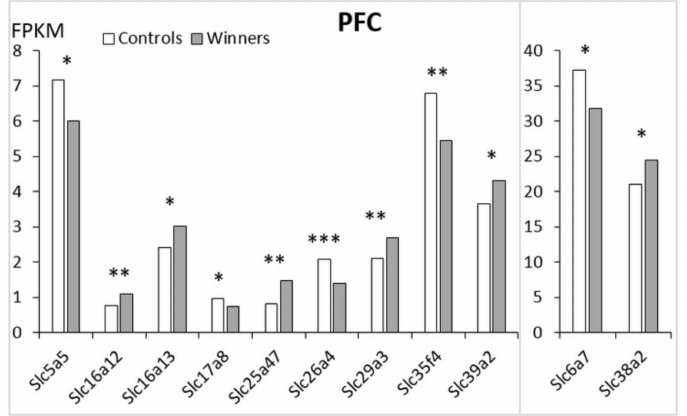
Figure 4. The Slc DEGs in the PFC of mice. White columns: controls; grey columns: winners. *: p < 0.05; **: p < 0.01; ***: p < 0.001. Additional information are shown in Supplementary Table S1.